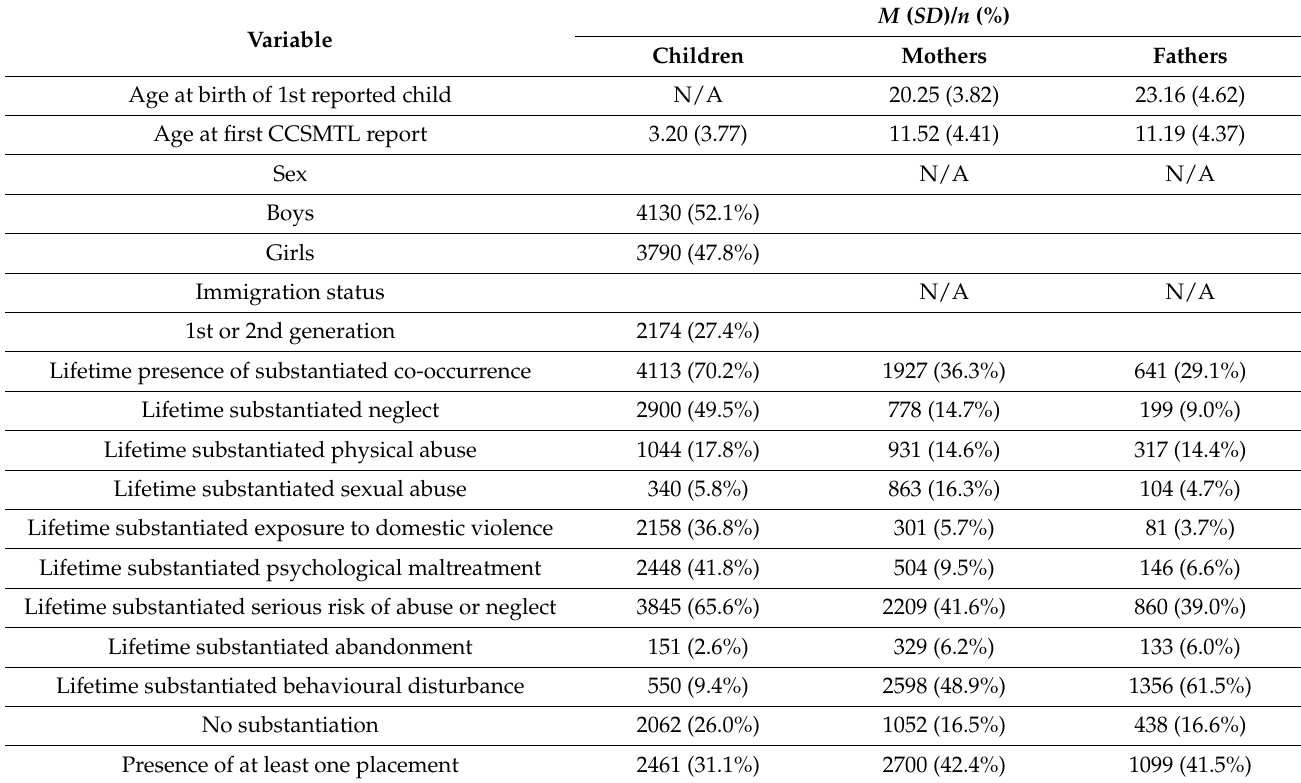
Table 1. Characteristics of the